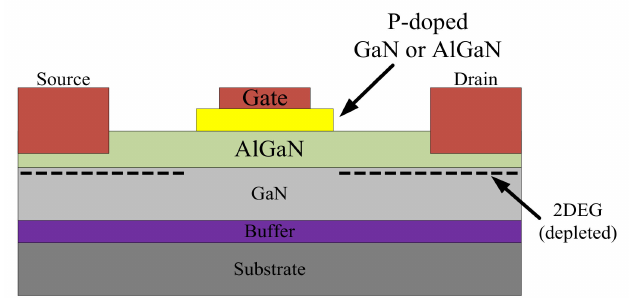
Figure 3. E-mode GaN